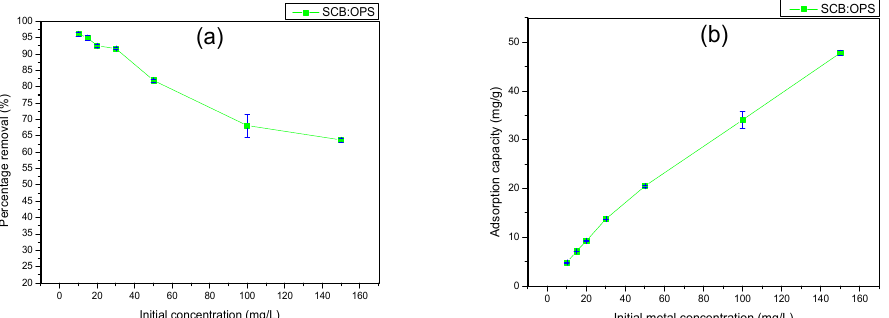
Figure 14. Effect of initial metal ion concentration: ( a ) Pb(II) percentage removal and ( b ) Pb(II) adsorption capacity.